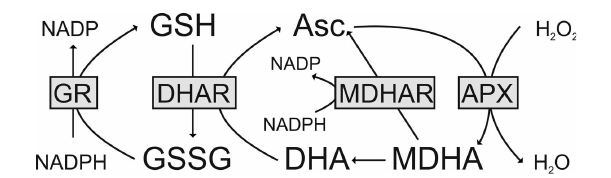
FIGURE 1 | The ascorbate–glutathione cycle in plants. Hydrogen peroxide (H 2 O 2 ) within the plant cell can be detoxified by ascorbate peroxidase (APX). In this reaction, the reduced form of ascorbate (Asc) is oxidized to monodehydroascorbate (MDHA). MDHA is then either reduced by monodehydroascorbate reductase (MDHAR) to Asc or, since very unstable, reacts to dehydroascorbate (DHA). DHA is reduced by dehydroascorbate reductase (DHAR) to Asc. In this reaction, the reduced form of glutathione (GSH) is oxidized to glutathione disulfide (GSSG). GSSG is then reduced by glutathione reductase (GR) to GSH. The electron acceptor NADP is regenerated during the reduction of MDHA and GSSG by the respective enzymes. Asc and GSH are additional able to detoxify reactive oxygen species by direct chemical interaction. Thus, besides the total ascorbate and glutathione level their redox state (reduced vs. oxidized state) which depends on the activity of the described enzymes (gray boxes) is also very important for successful plant